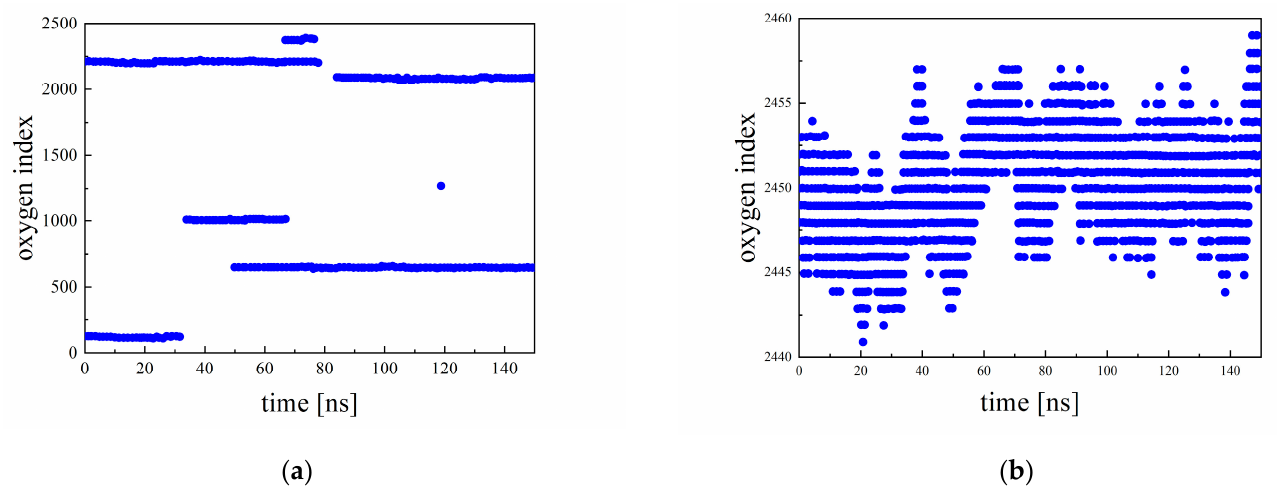
Figure 9. Examples of oxygen index as a function of time for ( a ) P(2EO-MO) at r = 0.01 and ( b ) PEO at r = 0.12.